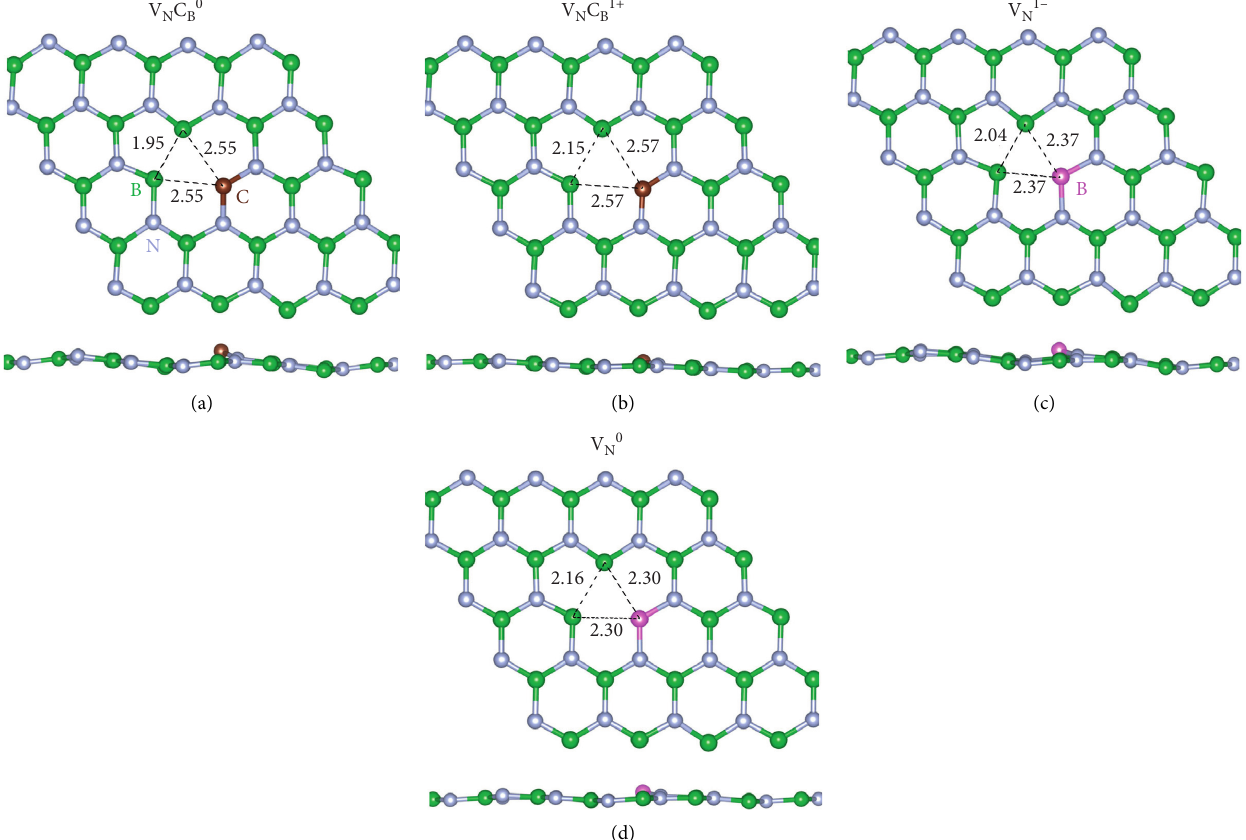
C V C V − charge state, and (d) neutral V N B , (b) N B in 1+ charge state, (c) N in 1 N . For